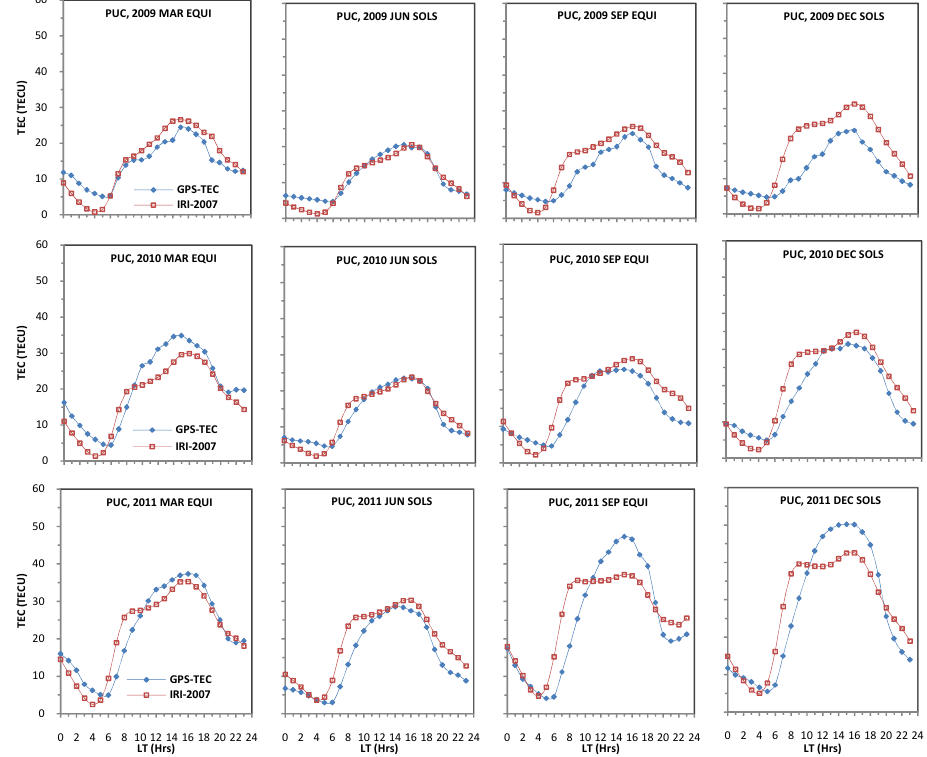
Fig. 6 . Comparison of the diurnal variation of the mean GPS-VTEC values (storm days were isolated) with those derived from the IRI-2007 NeQuick topside option for all seasons at Pucallpa (PUC) during 2009, 2010, and 2011 respectively. before the seasonal averaging for each local time hour,